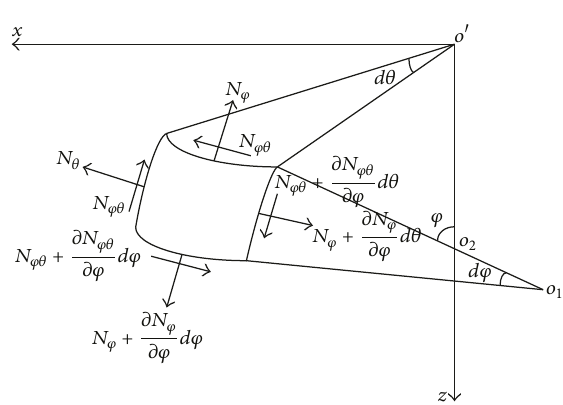
Figure 1: The diagram of deformed membrane.